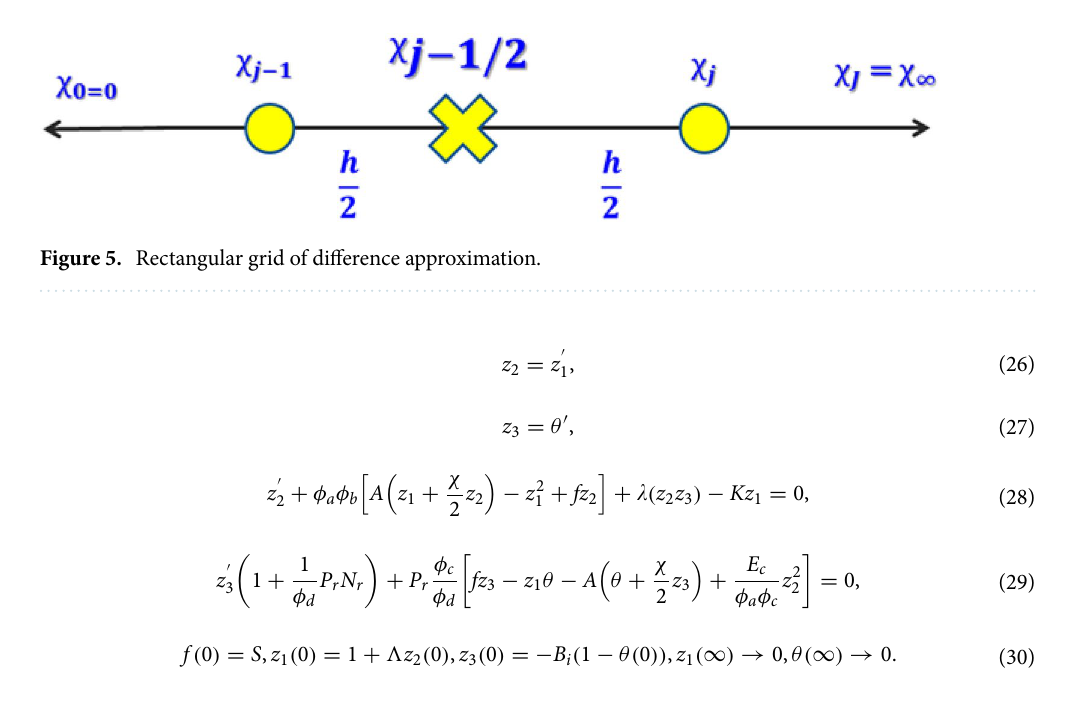
Figure 4. Chart of KBM steps.